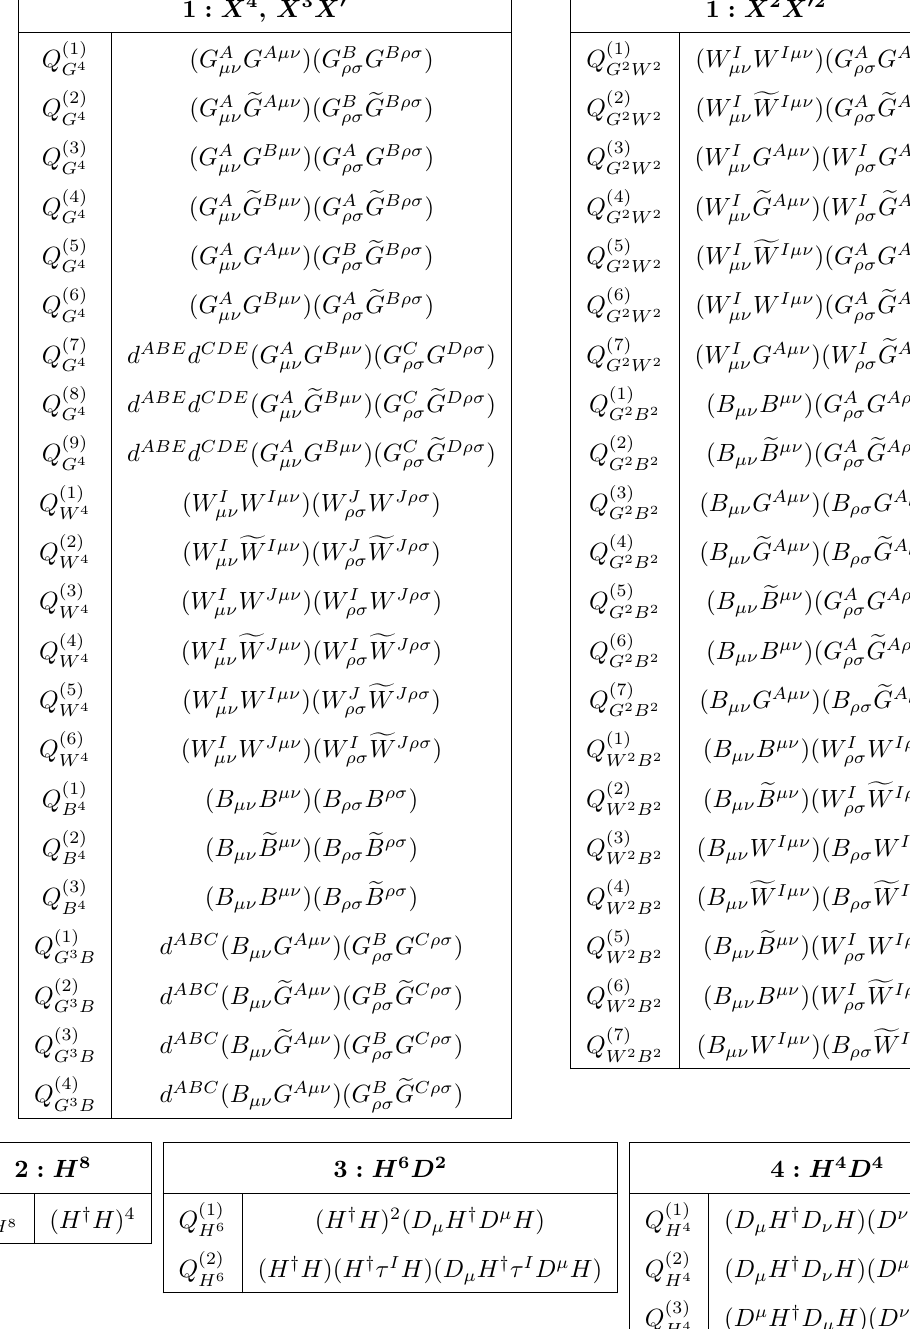
Table 2 . The dimension-eight operators in the SMEFT whose (cid:12)eld content is either entirely gauge (cid:12)eld strengths or Higgs boson